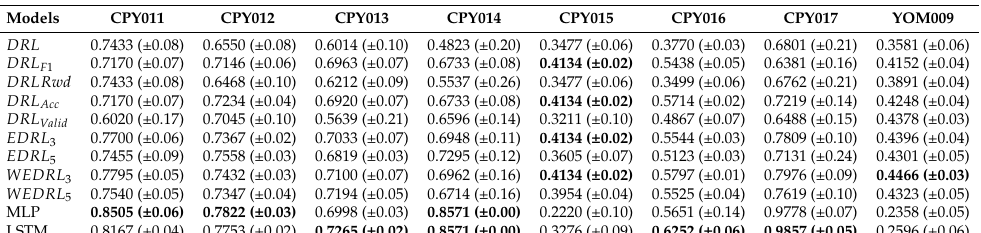
Table 10. The mean F1-scores and standard deviations of all of the DRL, MLP, LSTM, and ensemble of DRL-based models when testing with the dataset from different stations (the best F1-score of each station is shown in bold).